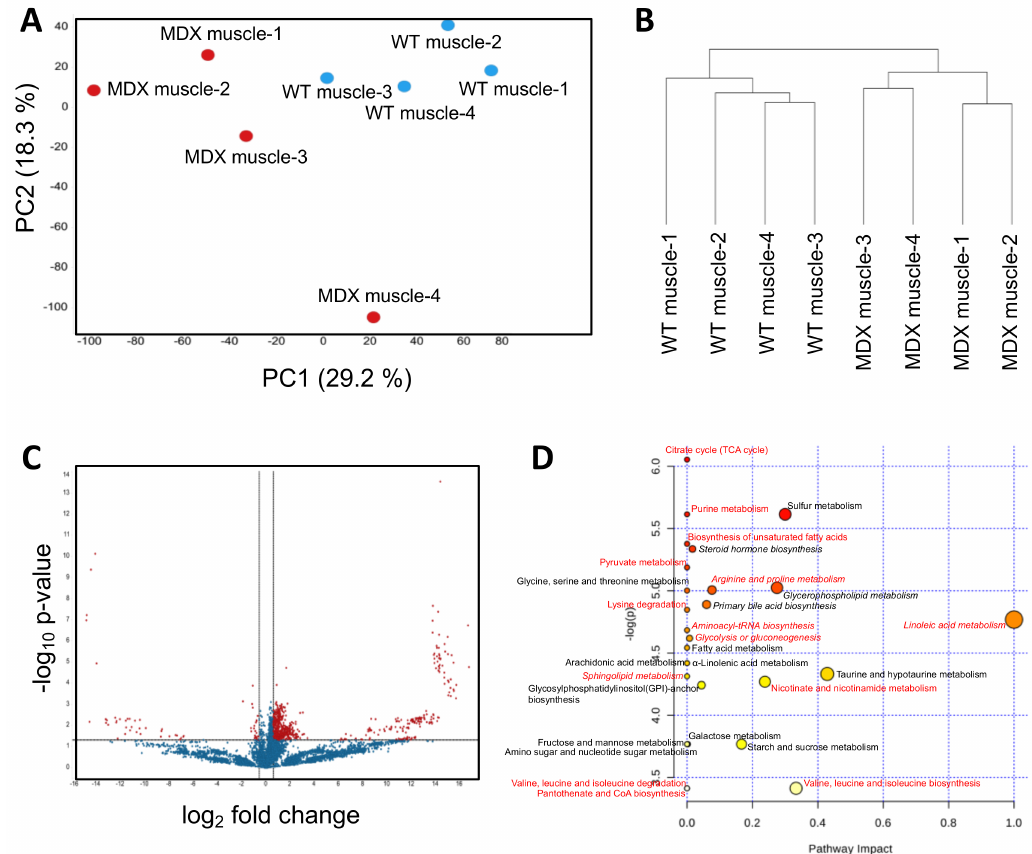
Figure 1. Metabolomic analysis of muscle satellite cells. ( A ) A principal component analysis (PCA) plot derived from nontargeted metabolite profiling of muscle satellite cells isolated from four WT control and four MDX mice. ( B ) A dendrogram depicting hierarchical clustering results of samples from ( A ). Clustering method: complete linkage. Distance measurement: Euclidean. ( C ) A volcano plot depicting differentially abundant metabolites (DAMs) between WT and MDX satellite cells (SCs). Horizontal and vertical dashed lines represent a threshold of p -value 0.05 and fold change 1.5, respectively. Seven-hundred-and-fifty-five features were identified to be significant from 11,151 features. ( D ) Pathway analysis of SC DAMs. Italics: pathways with multiple metabolites implicated. Red: metabolic pathways identified in both serum and muscle satellite cell